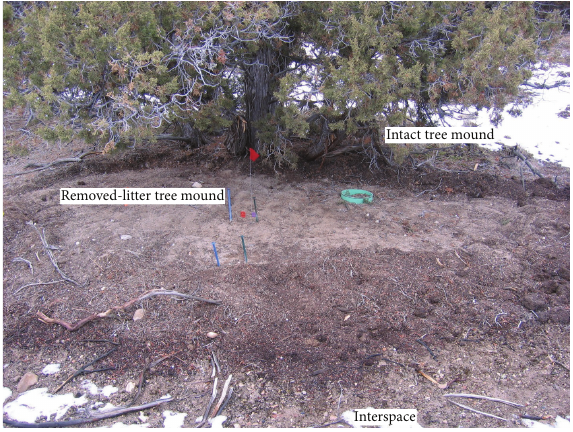
Figure 1: Untreated control area identifying microsite types. Figure 2: Masticated treatment area identifying microsite